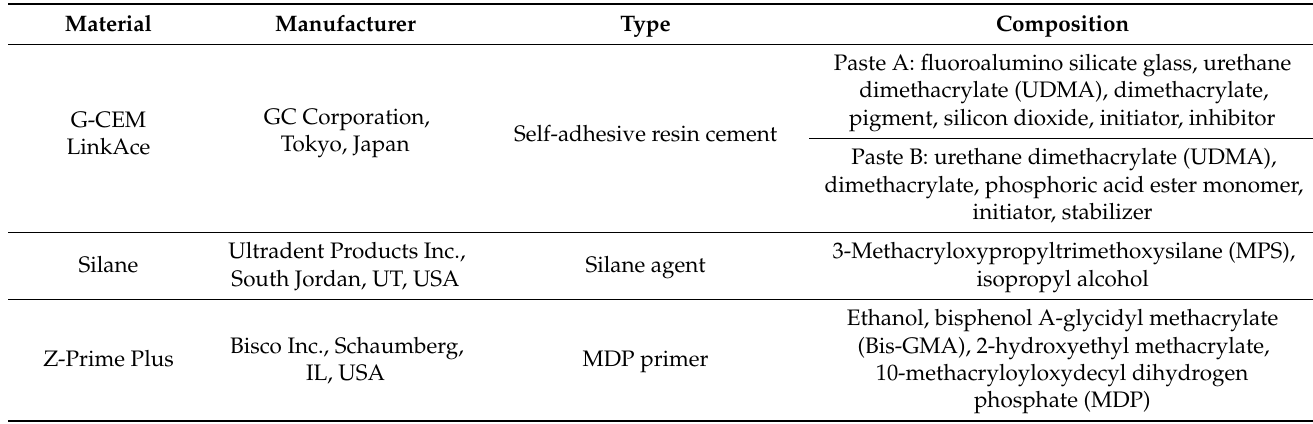
Table 2. Material properties used in retentive strength (RS)